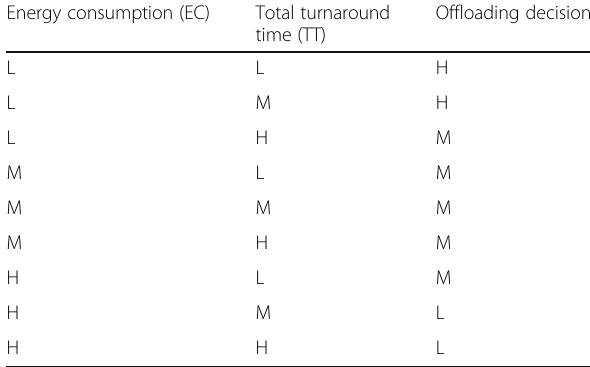
Table 4 Offloading decision